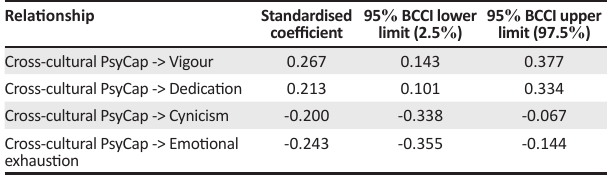
TABLE 5: Measurement model results of the second-order construct. Second-order First-order construct constructs Cross-cultural PsyCap